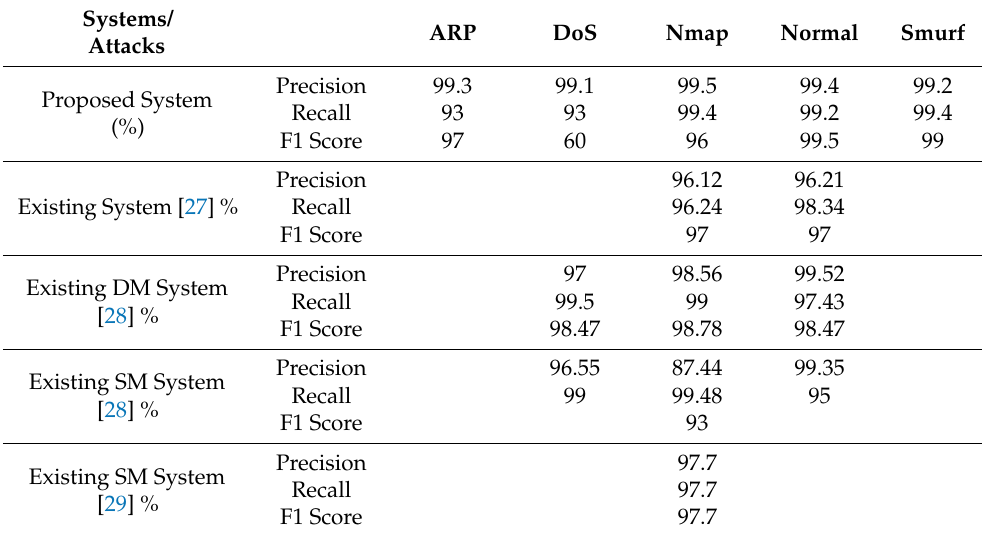
Table 2. Comparison of performance of proposed with existing system.